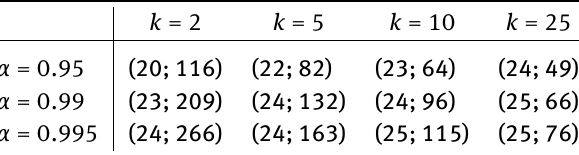
Table 5.3: VaR bounds in subgroup model with Gauss copula in A, B, and C and with t -copula in D, E, and F. ∆ denotes the differ- ence between upper bounds for k = 2 and k = 25 .